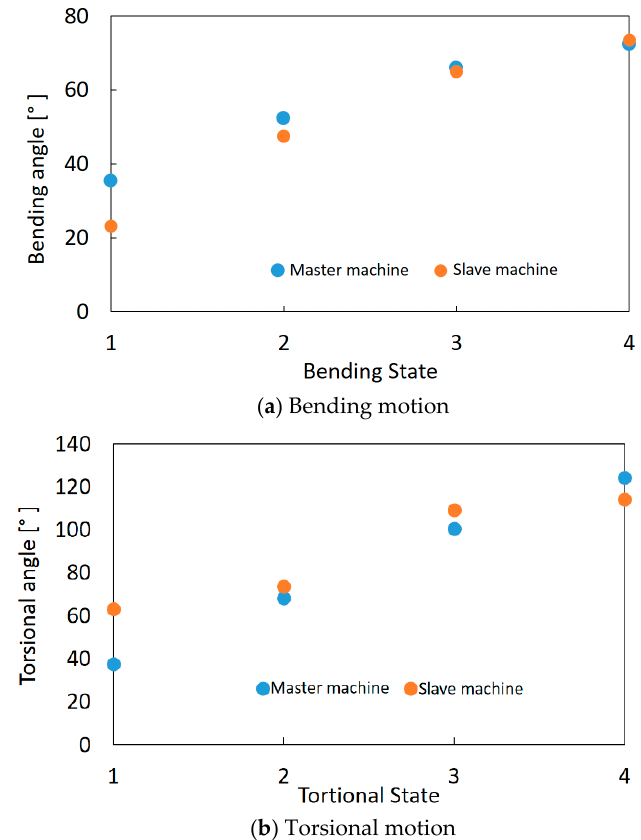
Figure 14. Comparison of the motions between the master machine and the slave machine through image analysis: ( a ) Bending motion. ( b ) Torsional motion.